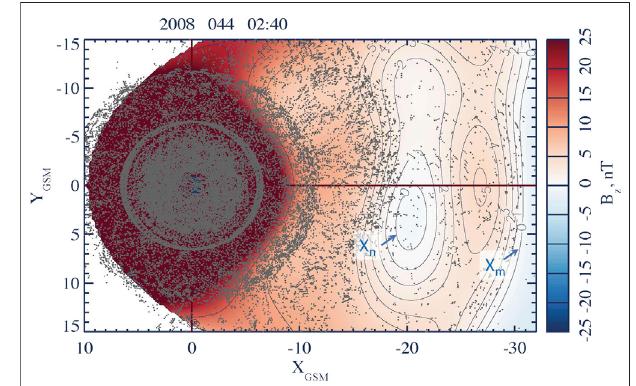
FIGURE2| TwoX-lines, X n and X m resolvedintheequatorialdistribution of the magnetic fi eld B z (using 0-degree tilt angle for the sake of visualization simplicity) as earthward parts of the contours B z in case of the 13 February 2008 substorm. The format of this fi gure is similar to that of Figure 1B . The projections of the spacecraft coordinates on the equatorial plane (gray dots) show that the NN subset of data for the moment considered is suf fi cient to resolve both